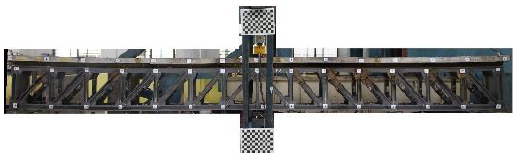
Figure 14. Layout position of chessboard used in current study.